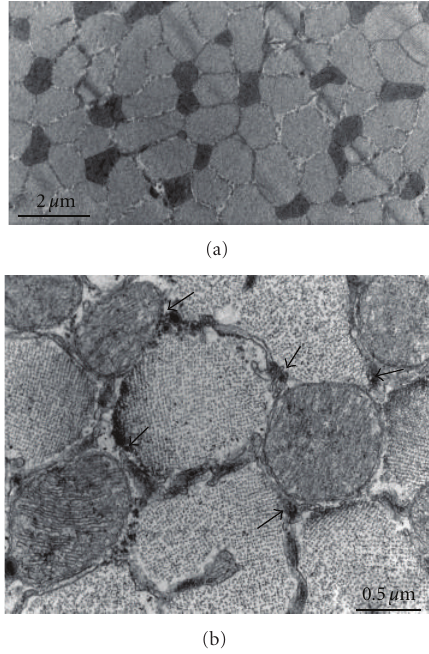
Figure 3: Breast muscle from the finch shown in cross-sections (a) and (b). In the finch, as in other birds, mitochondria are located in single longitudinally oriented rows between the myofibrils. A limited proximity between mitochondria and CRUs (arrows in (b)) occurs where the mitochondria cross the level at which T tubules are located. Accumulations of mitochondria at the fiber edges are not present in the flight muscles of many birds, indicating that the mitochondria are not free to escape from the myofibrillar domains of the fibers, probably due to tethering; see Figure 2.